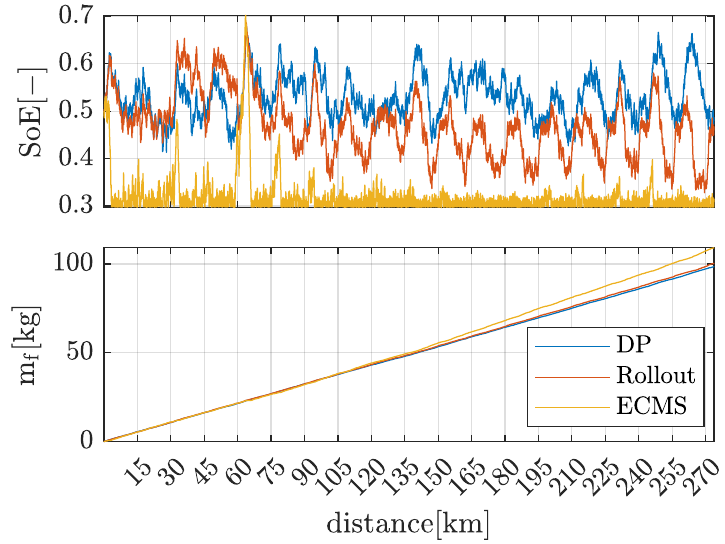
Figure 8. Comparison between the SoE and fuel consumption evolution obtained with DP assuming a priori knowledge of the route (optimal solution), the proposed online applicable method (roll out) and the standard online applicable method ECMS calibrated with a single loop.